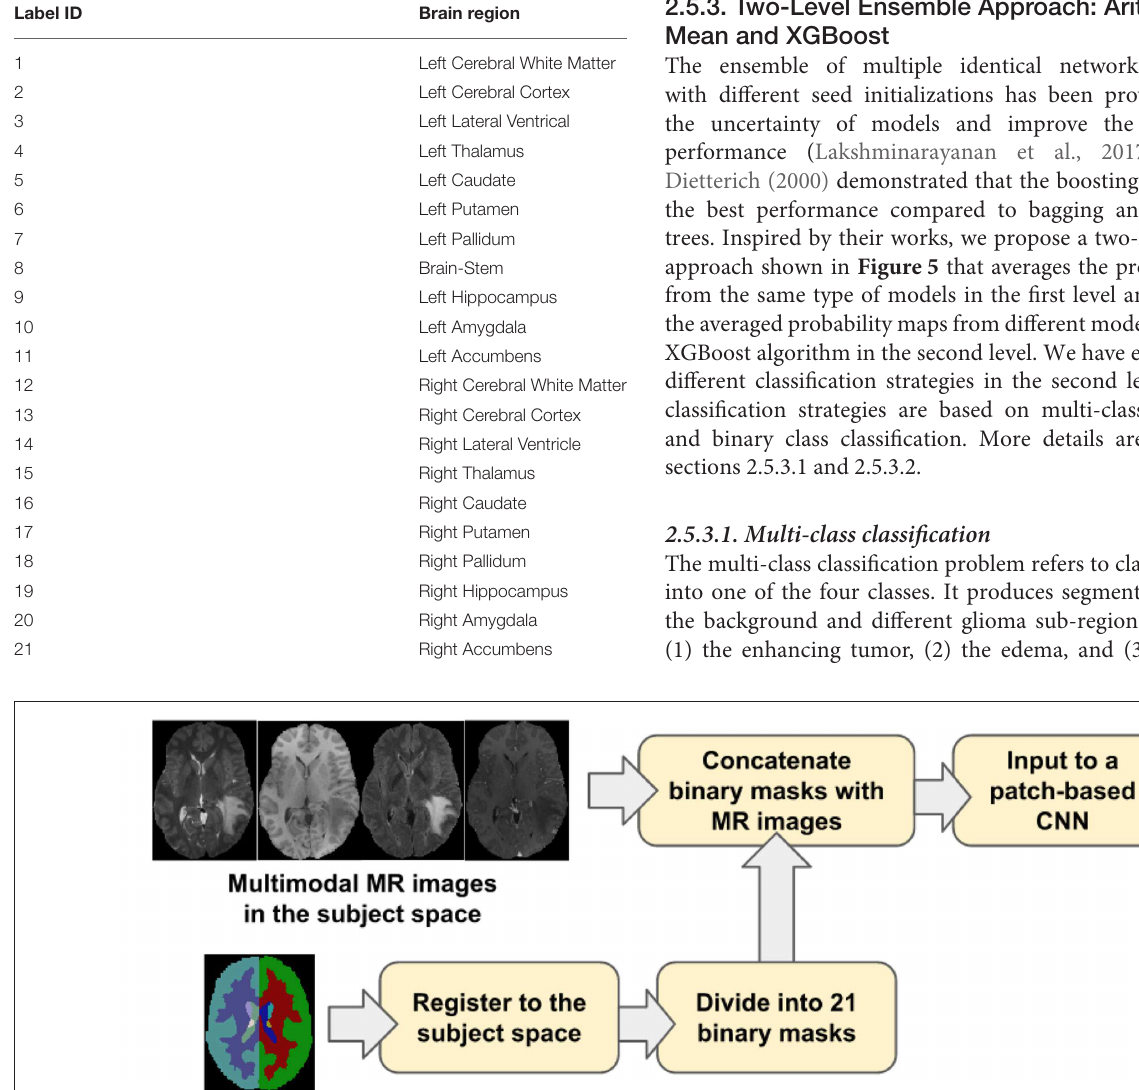
Frontiers in Neuroscience |